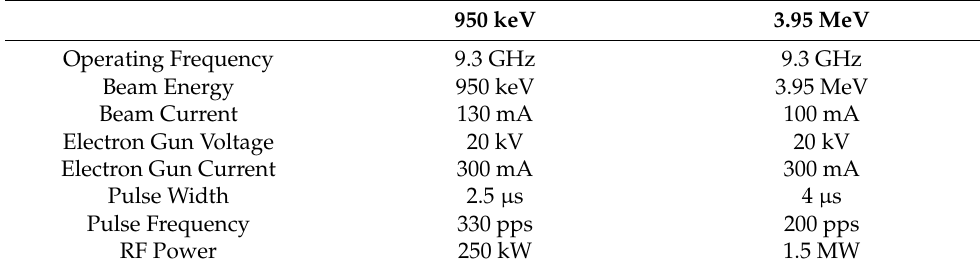
Table 1. Specifications of X-ray sources.